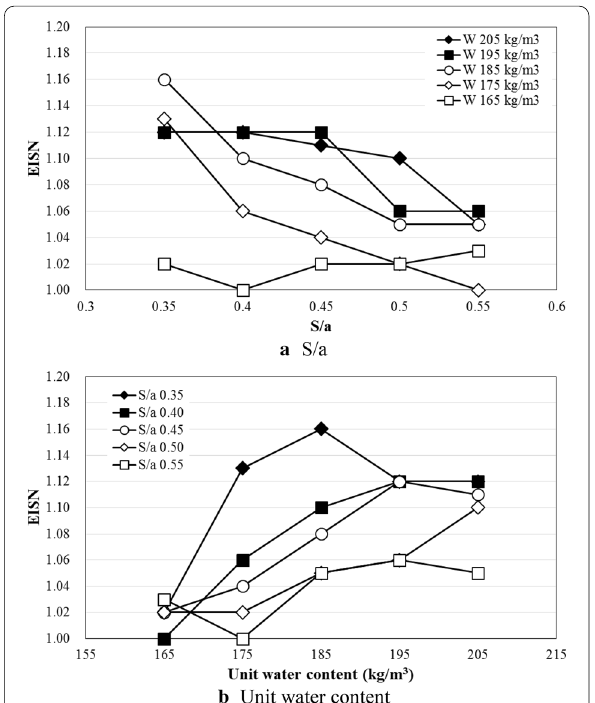
Fig. 7 Effects of S/a and unit water content on EISN of normal concrete mixtures.